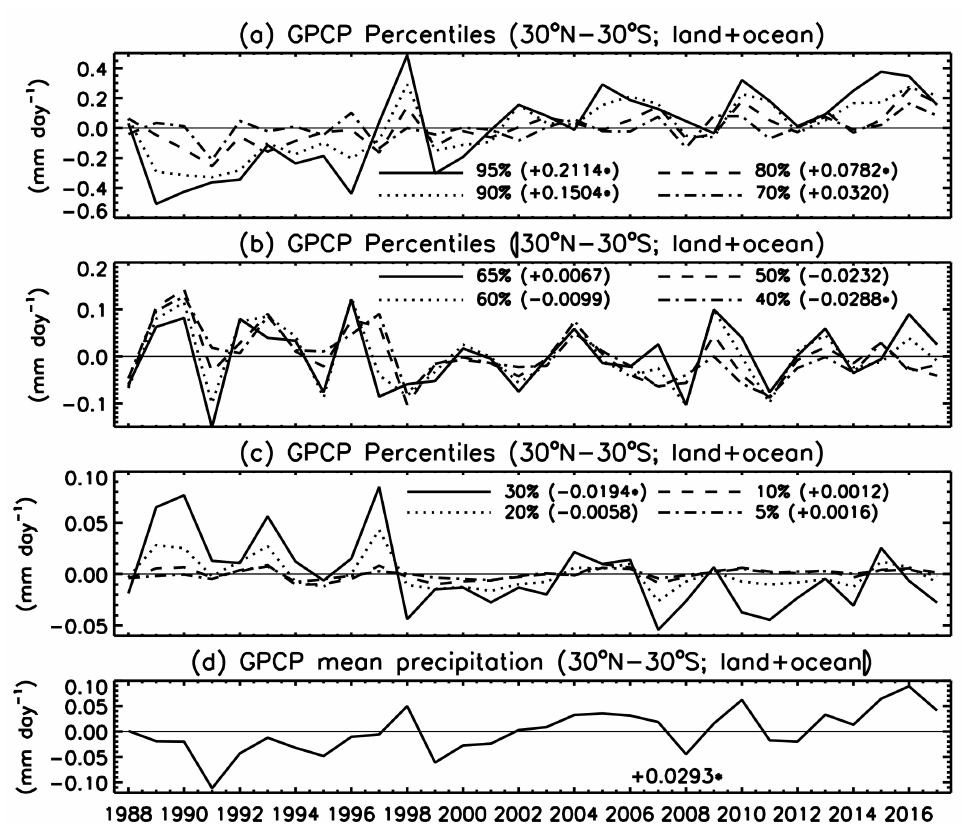
Figure 10. Annual anomalies of ( a – c ) precipitation percentiles and ( d ) mean precipitation determined by GPCP monthly rain rates for the latitude band 30 ◦ N–30 ◦ S (land + ocean). Also shown are their corresponding linear trends (mm day − 1 decade − 1 ), and those followed by “ * ” are statistically